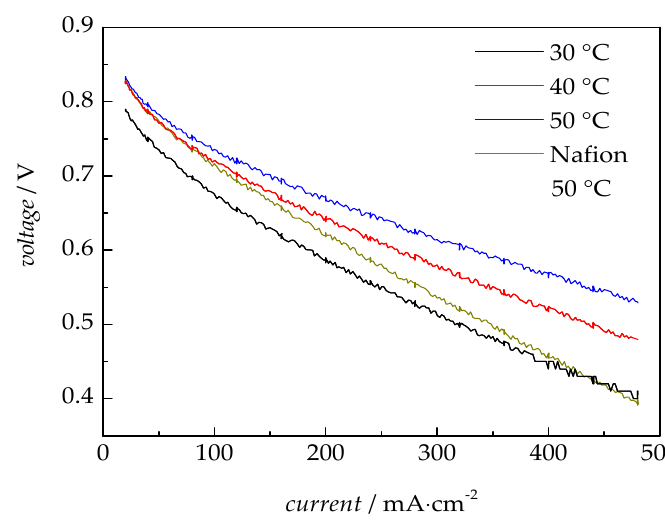
Figure 6. Polarization curves of sample #2 measured in a fuel cell from 30 to 50 °C after being kept at a current of 200 mA ∙ cm − 2 for five hours. For reference data for Nafion 117 measured at 50 °C is included. The open-circuit electrode potential of the fuel cell is temperature independent at 0.98 V.